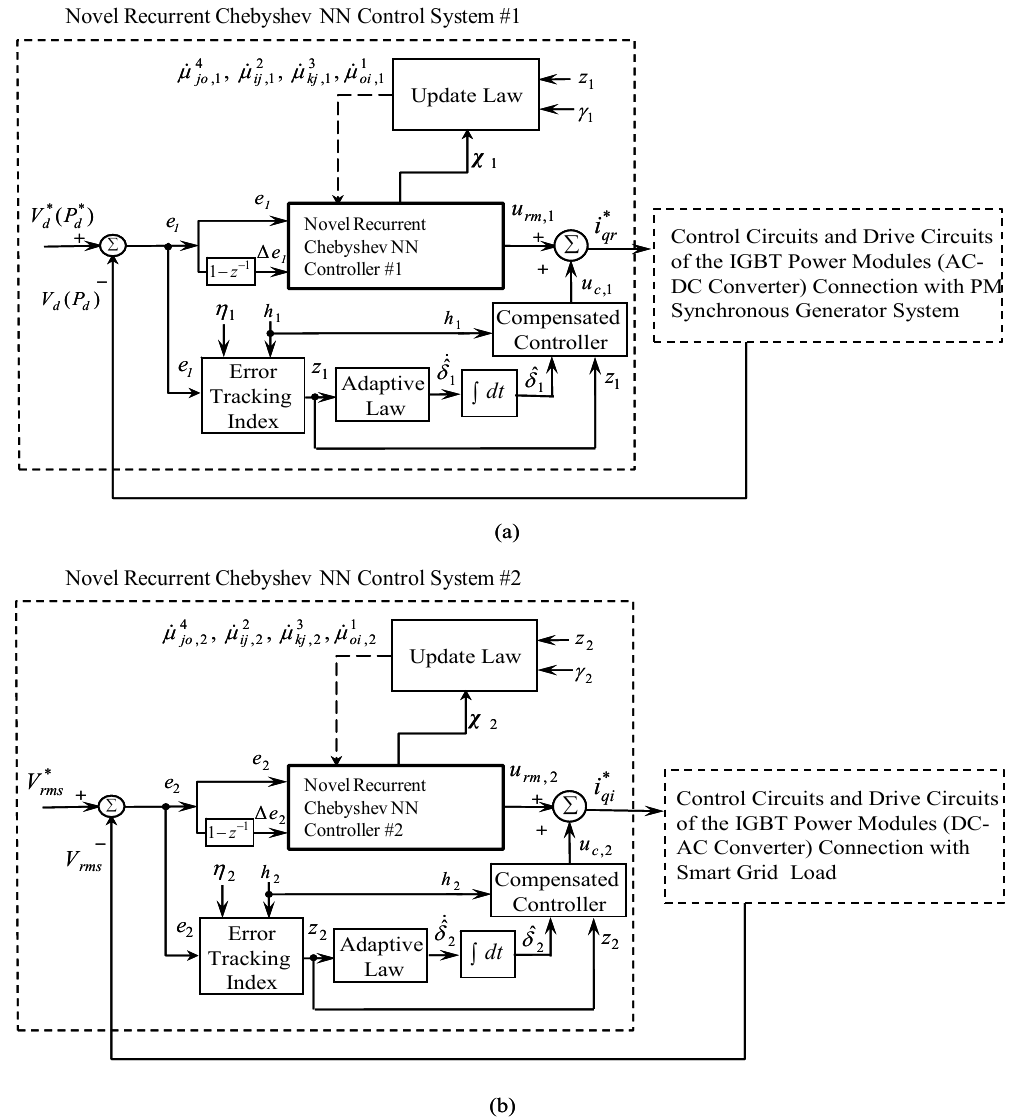
Figure 4. Block diagram of two sets of recurrent Chebyshev NN control systems for ( a ) AC ‐ DC converter and ( b ) DC ‐ AC converter.